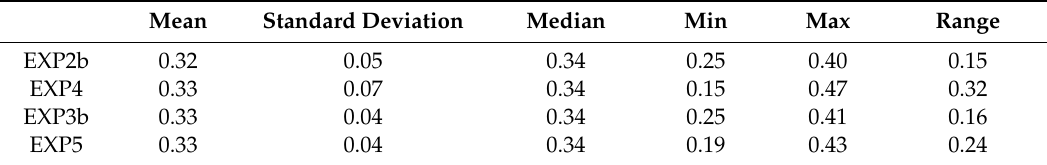
Table 26. VWC (m 3 m − 3 ) (0–10 cm) simulated by UTOPIA and NOAH, initialized with GLDAS, at the FB